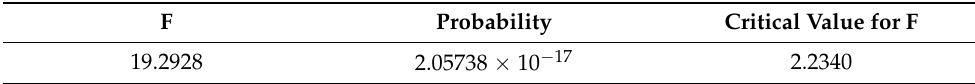
Table 8. ANOVA statistical test